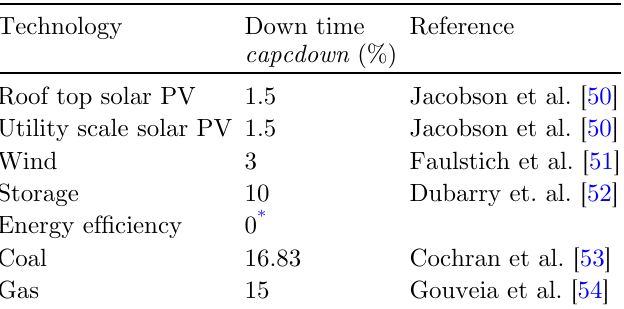
Table 6. Down time for different energy generation or storage technologies.